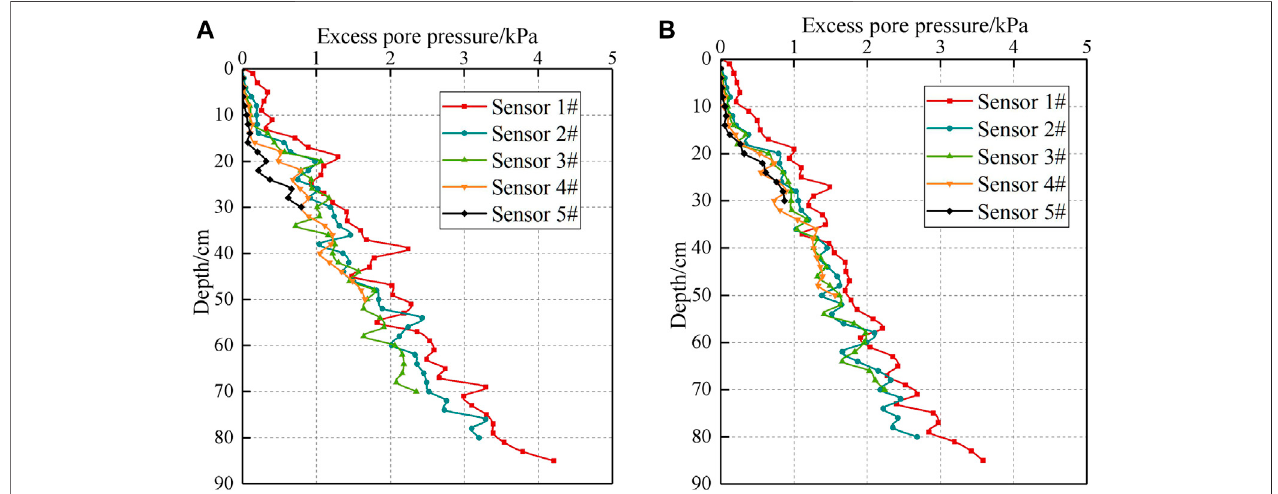
FIGURE 8 | Excess pore pressure curves at the pile surface with depth: (A) TP1 and (B) TP2.